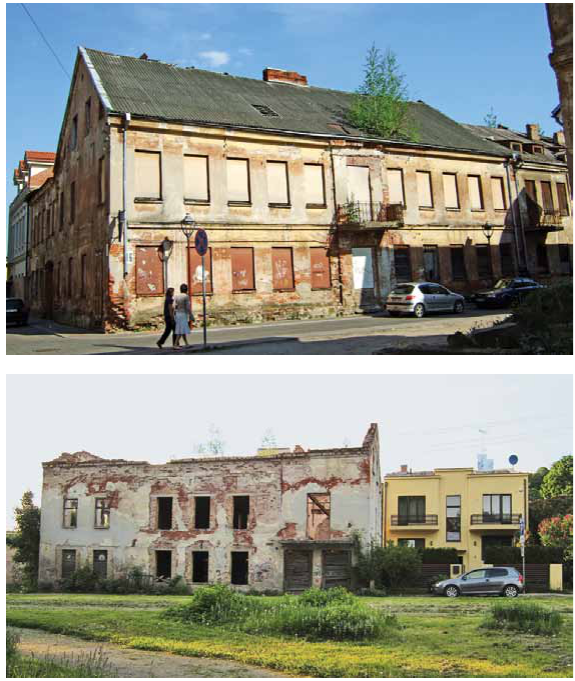
figs. 7, 8. unexploited houses (Kaunas, Palangos St., Totoriu St.) eventually turn to